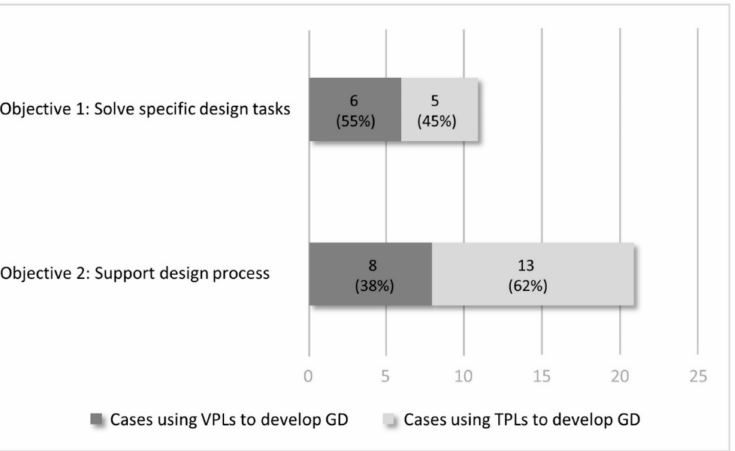
Figure 4. Application distributions of programming languages based on objectives of GD-BIM